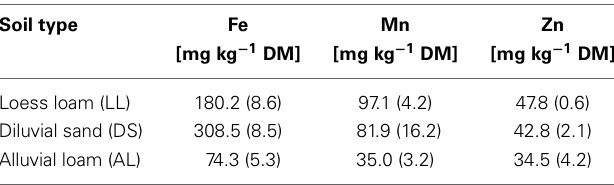
Table 5 | Micronutrient concentrations in leaf dry matter (DM) of different